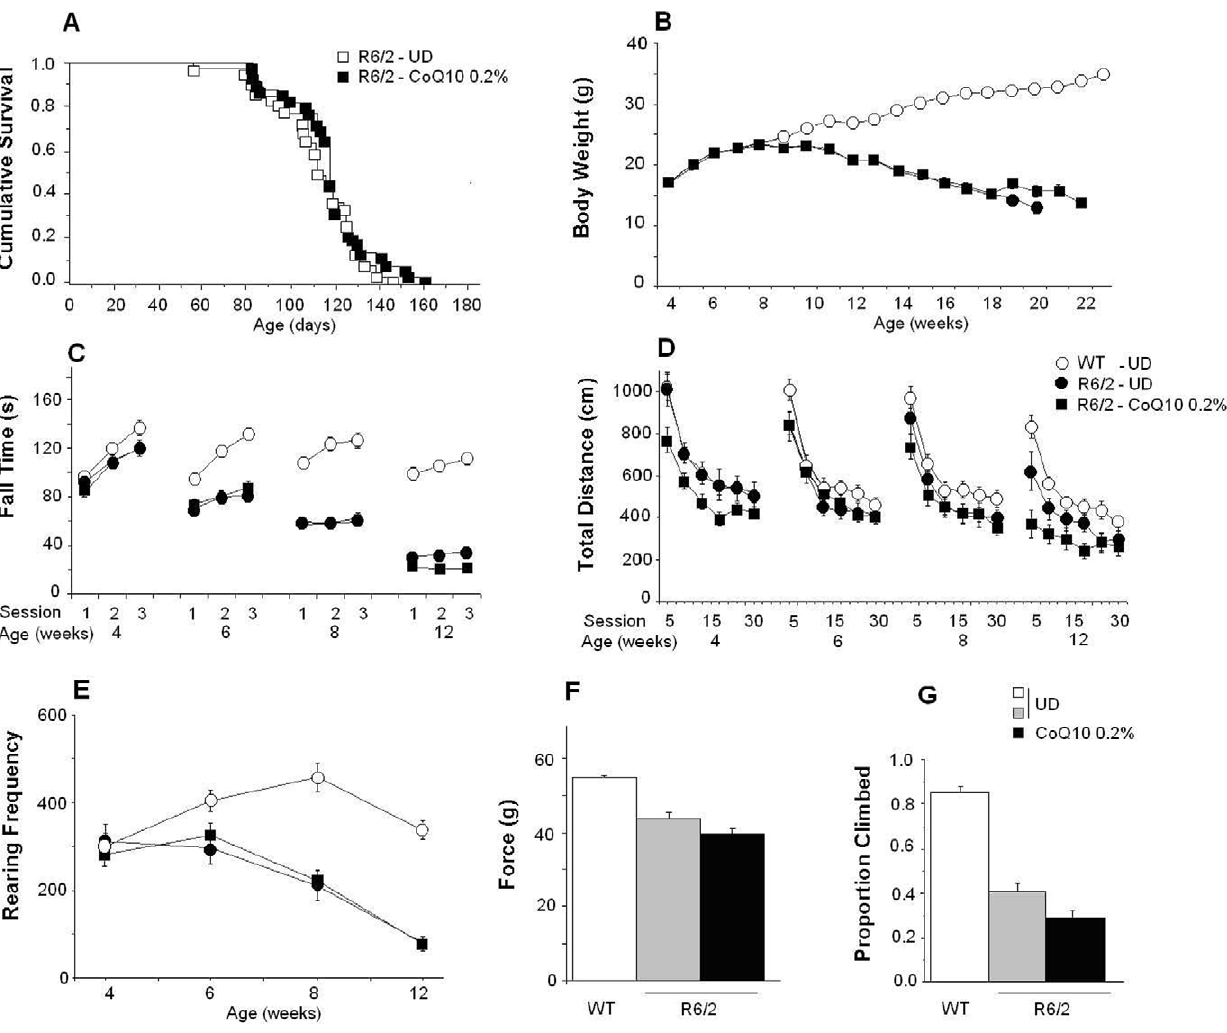
Figure 1. Effect of the administration of 0.2% of CoQ10 in food in R6/2 mice. WT mice received unsupplemented diet (UD) and R6/2 mice received either UD or 0.2% CoQ10. There were no significant treatment effects on survival (A), body weight (B) or rotarod (C: latency to